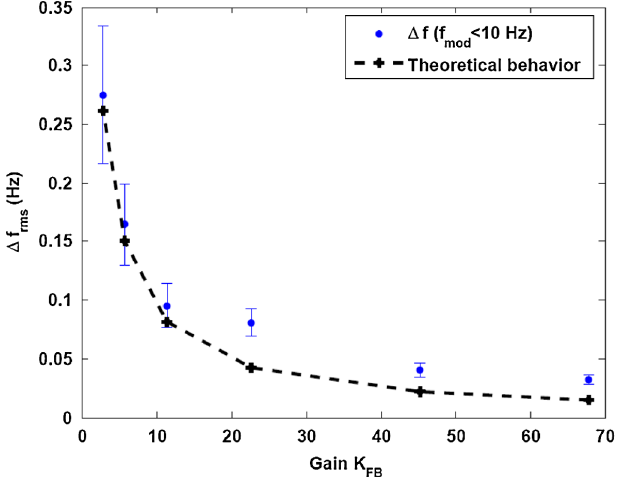
FIG. 15. (Color) Residual detuning error for modulating fre- quencies below 10 Hz to show the performance of the feedback part of the detuning compensation with the Saclay I tuner. The dashed black line shows the theoretical prediction for the given system properties.